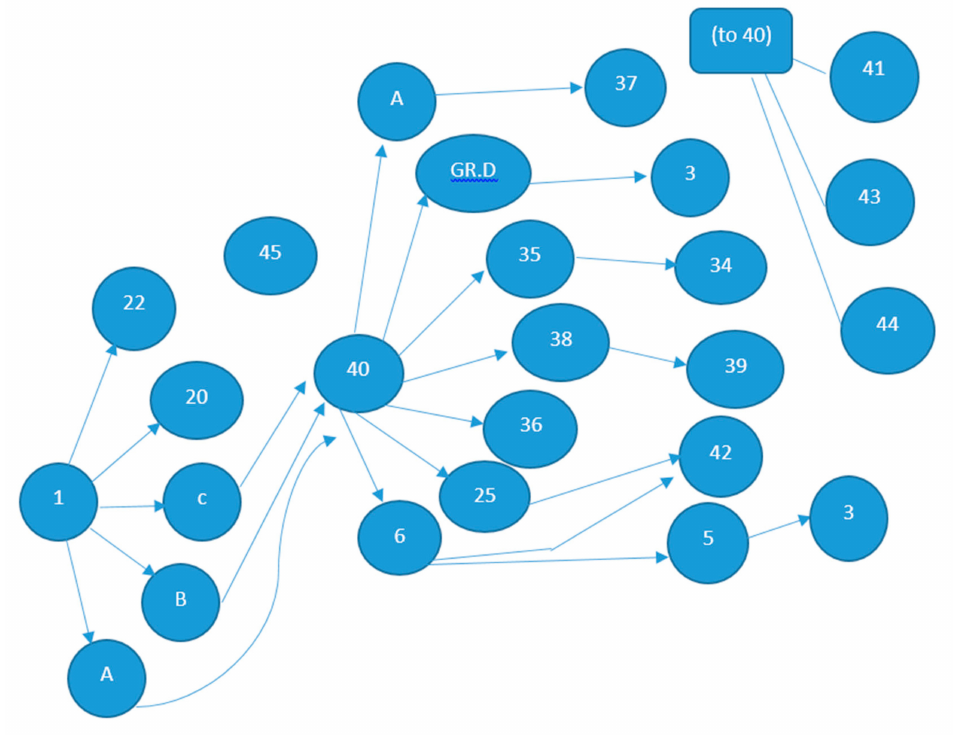
Figure 9. The RG created to generate the